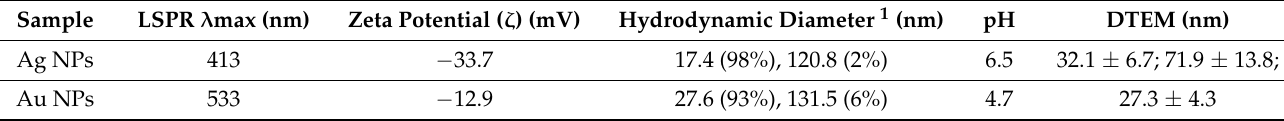
Table 2. The characteristics of the Ag and Au samples.